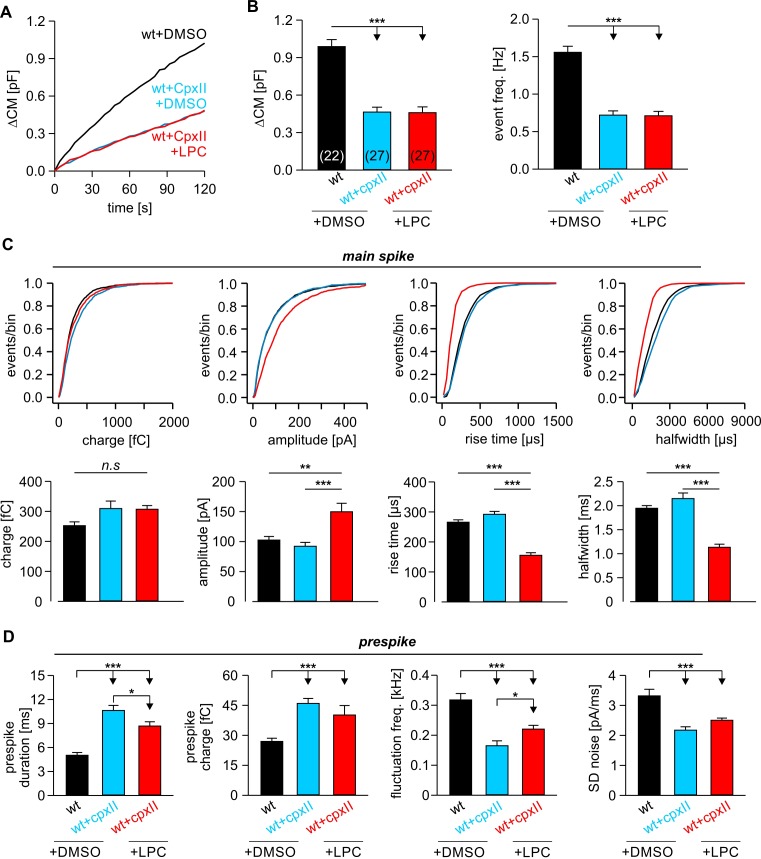
LPC fails to rescue the CpxII mediated prolongation in the expansion time of the nascent fusion pore.(A) Stimulus evoked averaged ∆CM for the indicated groups. (B) The CpxII mediated reduction of total ∆CM (left panel) and the amperometric event frequency (right panel) is unaffected by application of LPC. Numbers indicate analyzed cells. (C) Cumulative frequency distributions (top panels) and cell-weighted averages (bottom panels) show that extracellular LPC speeds up the kinetics of the main spike in CpxII expressing cells. (D) CpxII selectively slows down the kinetics of prespike phase. Application of LPC largely fails to restore the CpxII mediated deceleration of neurotransmitter release from single vesicle. Values are given as mean of median determined from the indicated parameter’s frequency distribution for each cell. Data were collected from cells/events measured for wt+extra.DMSO (22/2171), wt+CpxII+extra.DMSO (27/995), and wt+CpxII+extra.LPC (27/1098). Only cells with >20 events were considered. Data are represented as mean ± SEM. *p<0.05, **p<0.01, ***p<0.001, one-way analysis of variance followed by Tukey-Kramer post test.